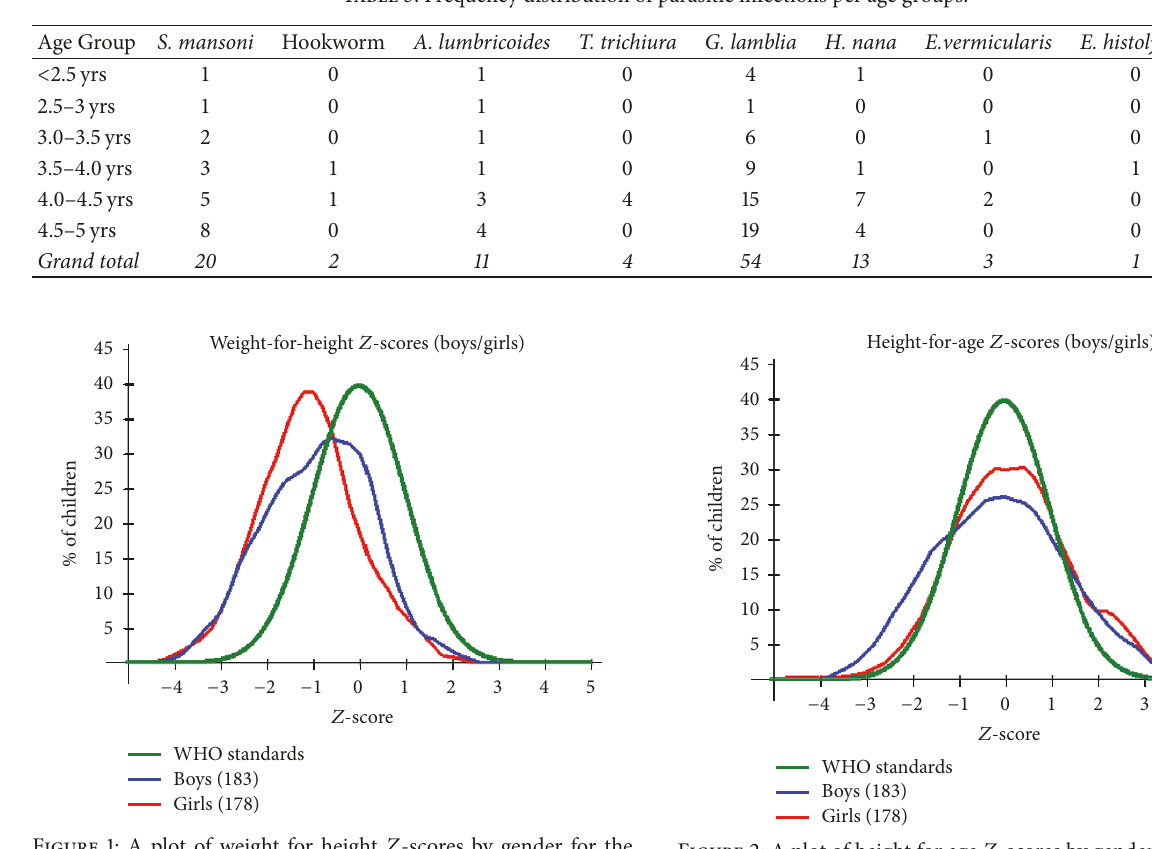
Table 5: Frequency distribution of parasitic infections per age groups.